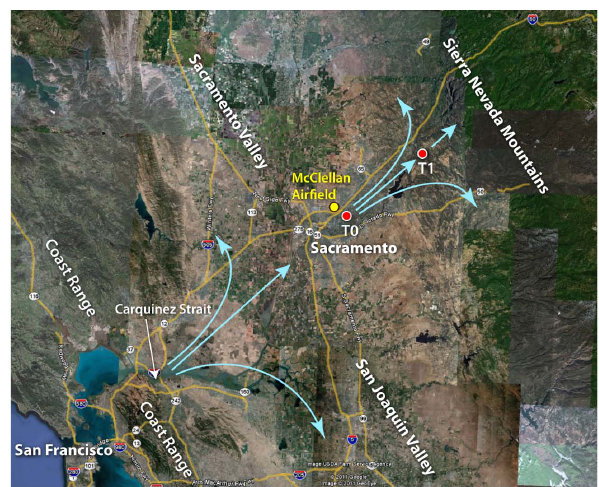
Fig. 1. Locations of the ground sites “T0” (latitude: 38.6483, longitude: − 121.3493, altitude: ∼ 30mm.s.l.) and “T1” (latitude: 38.8711, longitude: − 121.0228, altitude: ∼ 450mm.s.l.). Light blue arrows indicate typical daytime flow pattern in the region dur- ing